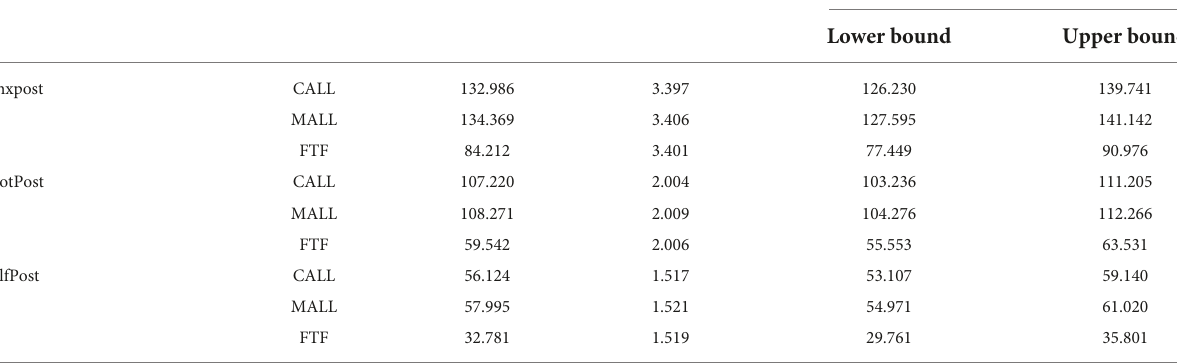
TABLE 5 Results of